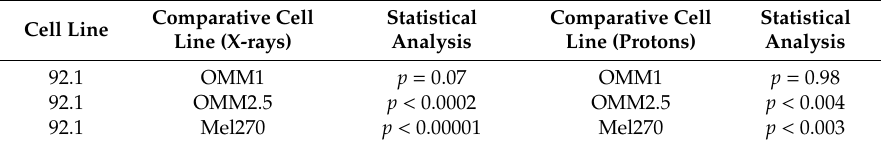
Table 1. Comparative survival of UM cells in response to photons and protons.